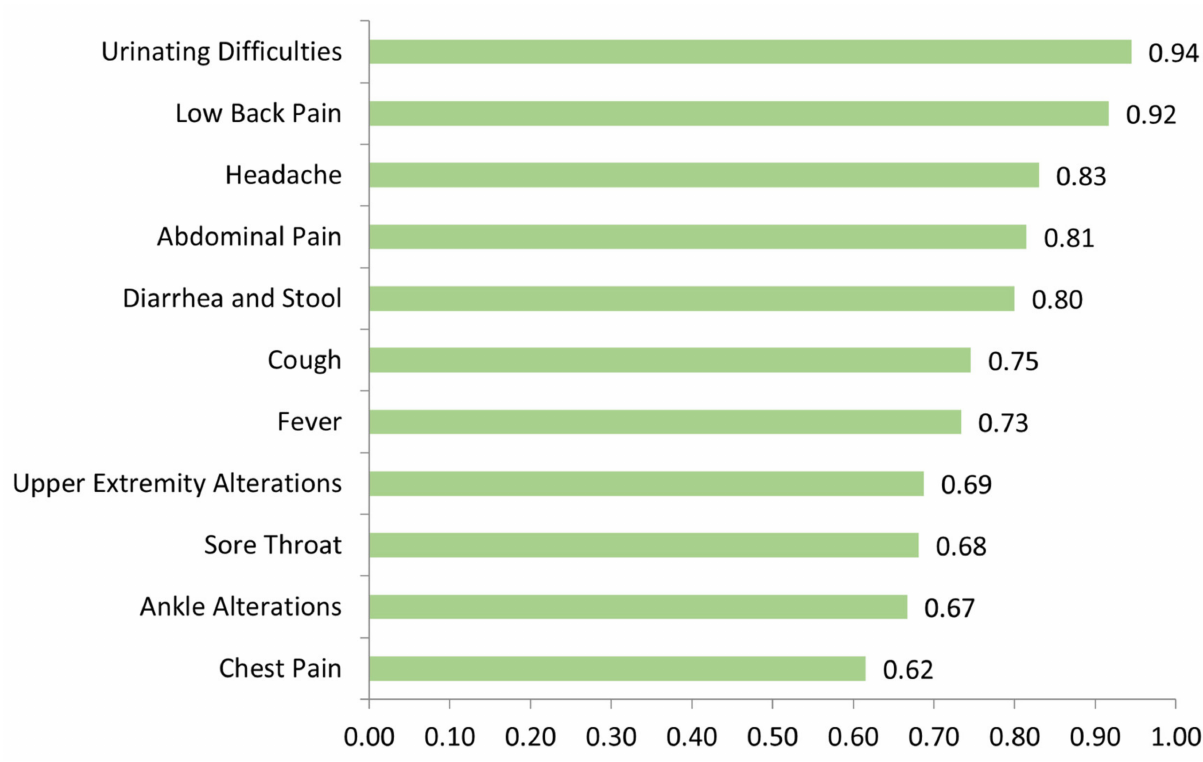
Figure 4. WW triage accuracy (from 0 to 1, with 1 equal to 100% accuracy) for the most frequent symptoms attending